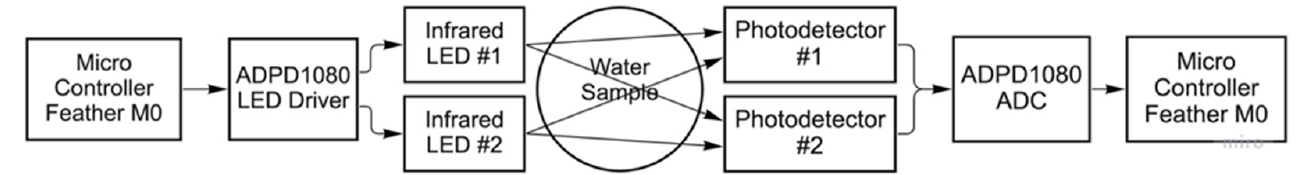
Figure 3. Block diagram of the OpenProbe GLI-2 sensor.